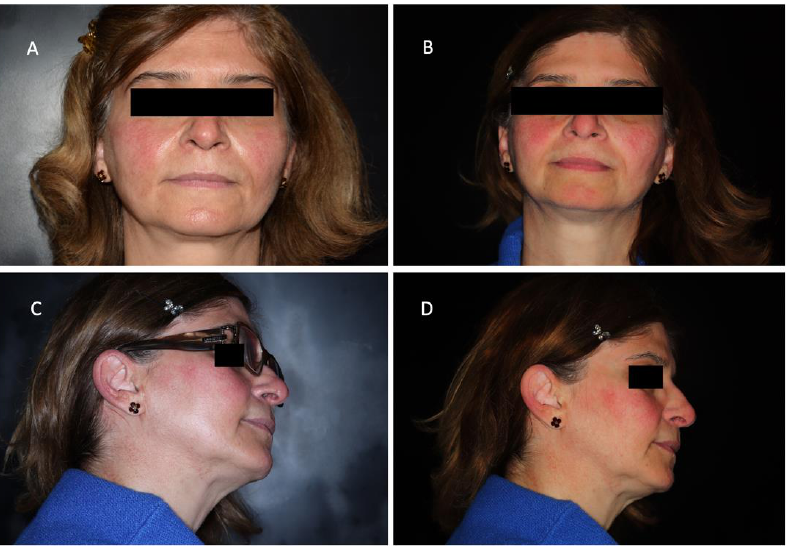
Figure 4. Clinical photos showing the erythema of the face, with malar rash-like distribution ( A ) and sparing of the nasolabial fold ( B ); the papular rash involving the ears ( C ) and sparing the cheeks ( D ).